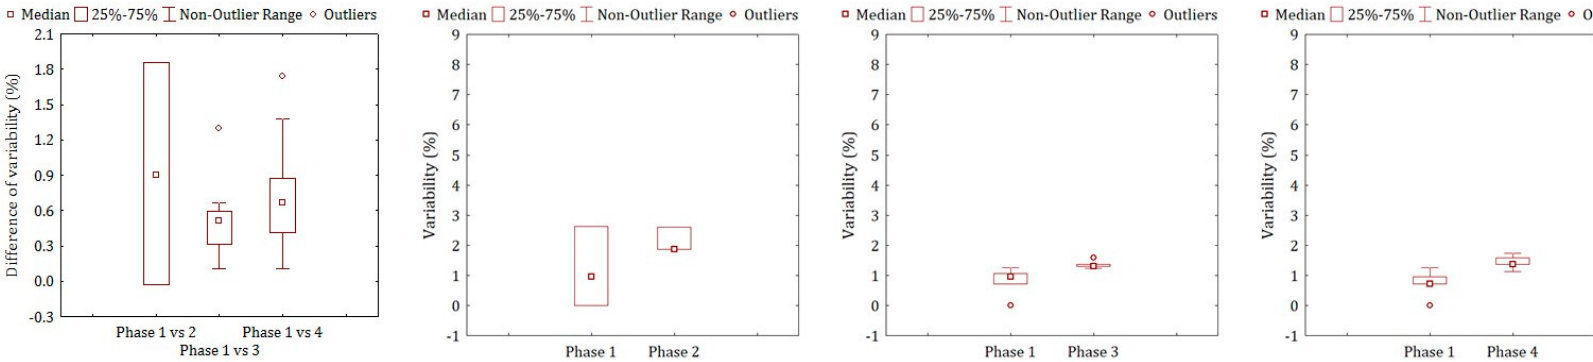
Figure 10. The comparison of the variability of low flows in different phases during the forest harvesting period. Table 8. Differences significance tests of low flow regime components in hydropower dam disturbance period.